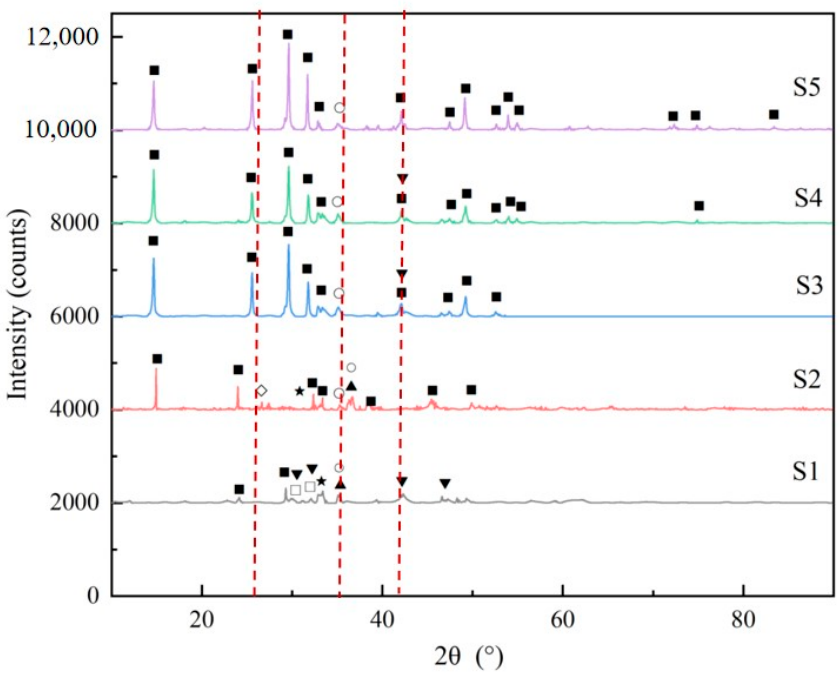
Figure 5. XRD patterns of slag samples titrated by simulated AMD. The following compounds were identified: ( ■ ) CaSO 4 ·0.5 H 2 O; ( ○ ) CaFeSi 2 O 6 ; ( ▲ ) Mg-Al hydrotalcite; ( ◊ ) CaO; ( ▼ ) Ca 2 SiO 4 ; ( ★ ) RO, (Mg, Mn, Ca) x Fe 1-x O; ( □ ) Ca 3 SiO 5 . To investigate the phase change for a single component of real steel slags in acid solu- tions, thermodynamic calculation was used to explore the priorities of different minerals. Possible reactions between slag components and simulated AMD (0.1 M H 2 SO 4 ) were listed in Table 2. The related Gibbs free energy changes for the reactions indicated that the reaction sequence of components with simulated AMD was CaO > MgO > FeO > C 2 S > C 2 F > C 3 S under room temperature [12]. However, some synthetic pure Ca- and Mg-bearing minerals studied by leaching experiments and thermodynamic analysis thought that the leaching order for different phases is CaO > (Ca 3 Al 2 O 6 , γ -Ca 2 SiO 4 , Ca 3 MgSi 2 O 8 , and Ca 2 MgSi 2 O 7 ) > (Ca 12 Al 14 O 33 , and Ca 2 Fe 2 O 5 )